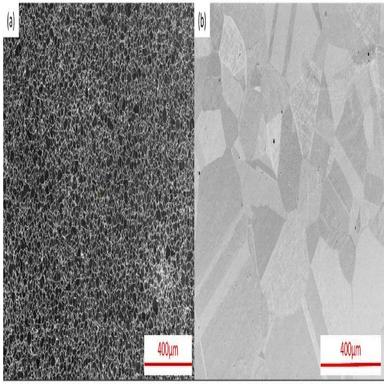
SEM images of samples (a) as received and (b) after heat damage. The delta phase is now seen in white for the as-received sample, and are absent after heat damage as occurred. Again, the γ′ and γ'' phases are beyond the resolution of the SEM.